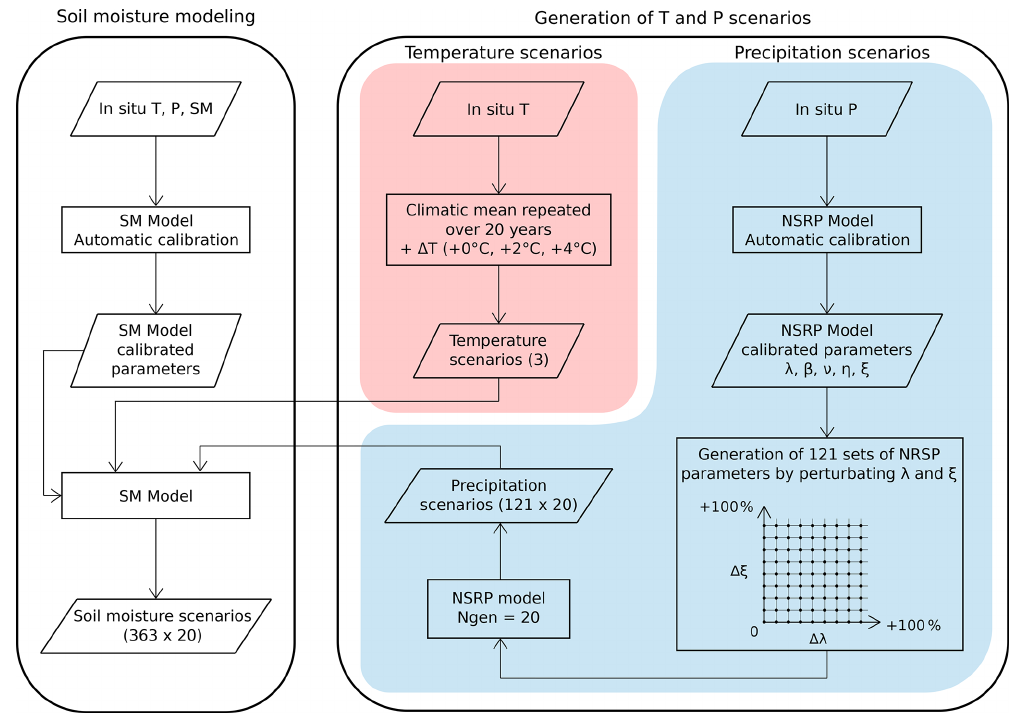
Figure 3. Flowchart of the experimental design for the simulation of the soil moisture